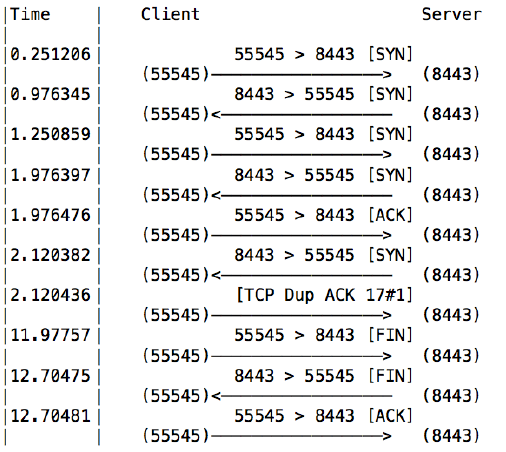
Figure 7. Example of a failed TCP